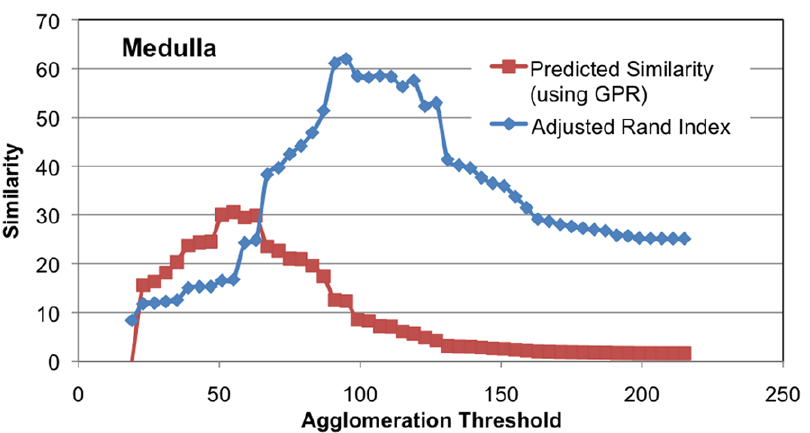
Figure 9. The poor predictiveness of GPR similarity measure compared to the actual adjusted Rand index. While the agglomeration is based on mean intensity as in Figure 7, the quality of the edge probabilities is degraded by only using mean intensity as a feature for computing edge probability, thus leading to poor correspondence between GPR and the adjusted Rand index.